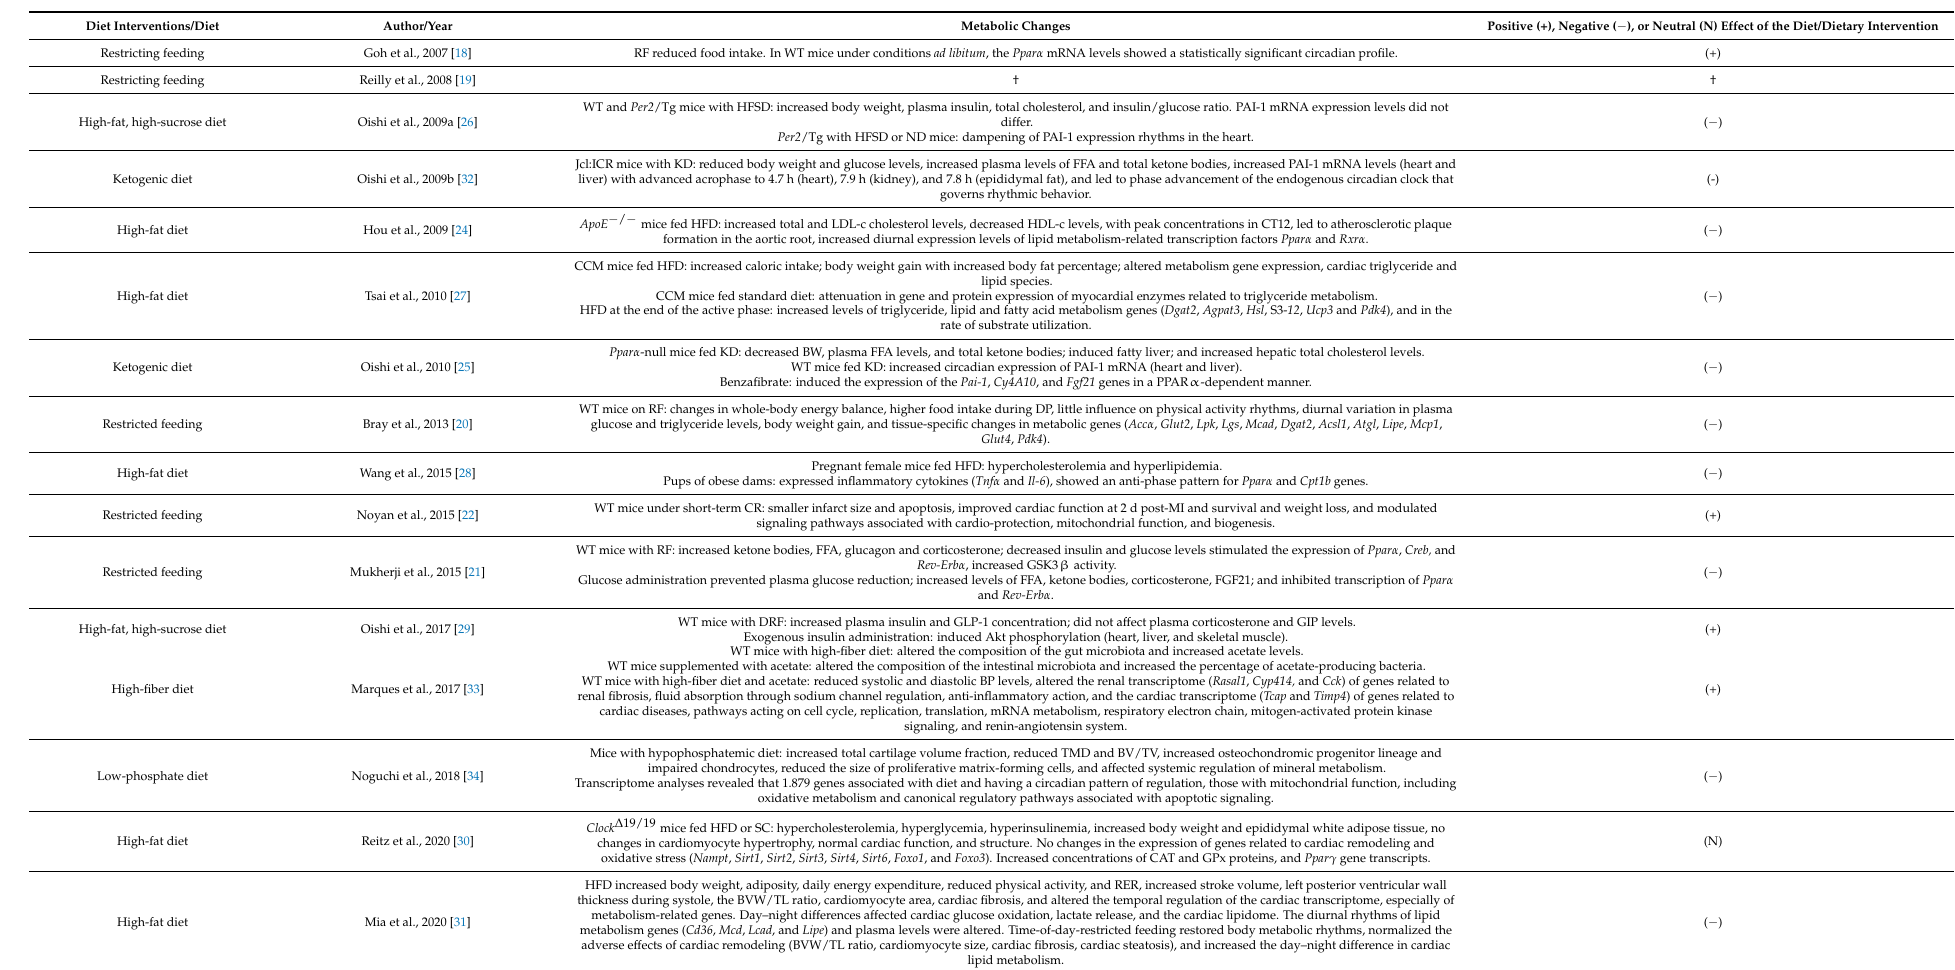
Table 4. Authors, year of publication, and the results